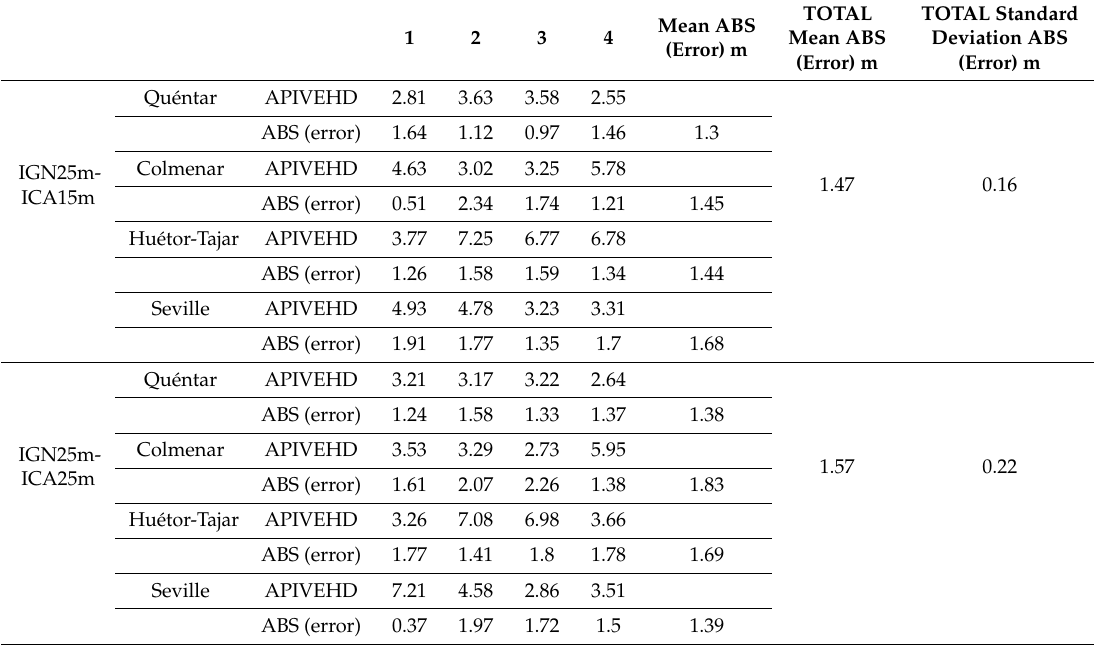
Table 11. APIVEHD obtained by comparison between the homologous pairs DEMs IGN25m-ICA15m and between the homologous